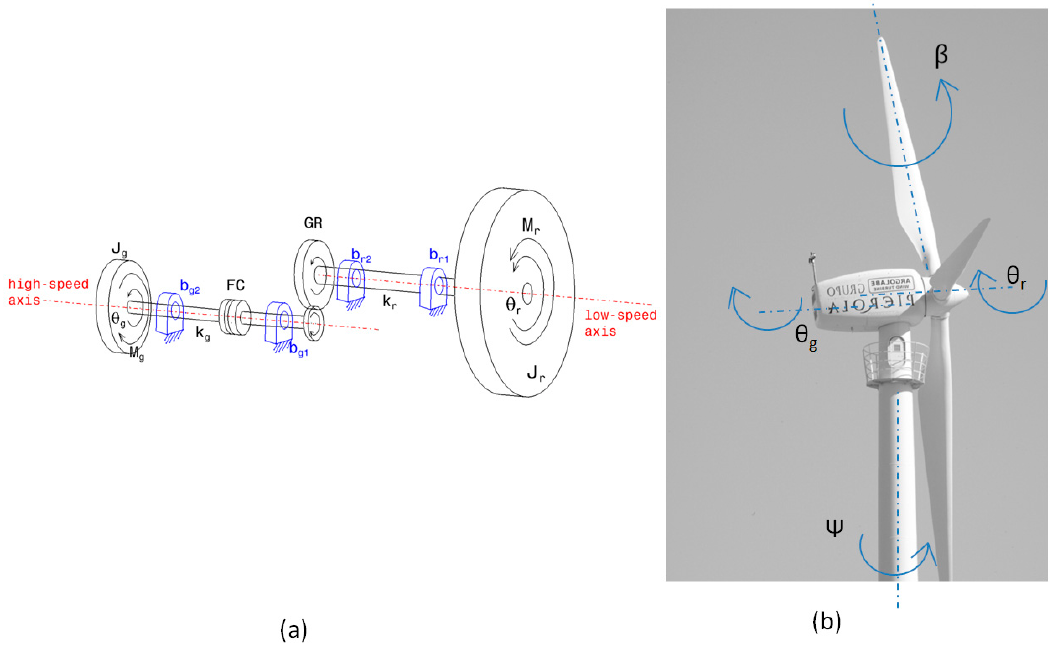
Figure 1. Argolabe S.L. Engineering Company Wind Turbine: ( a ) Drive train of the power system; ( b ) Picture of the wind turbine with the main axes.